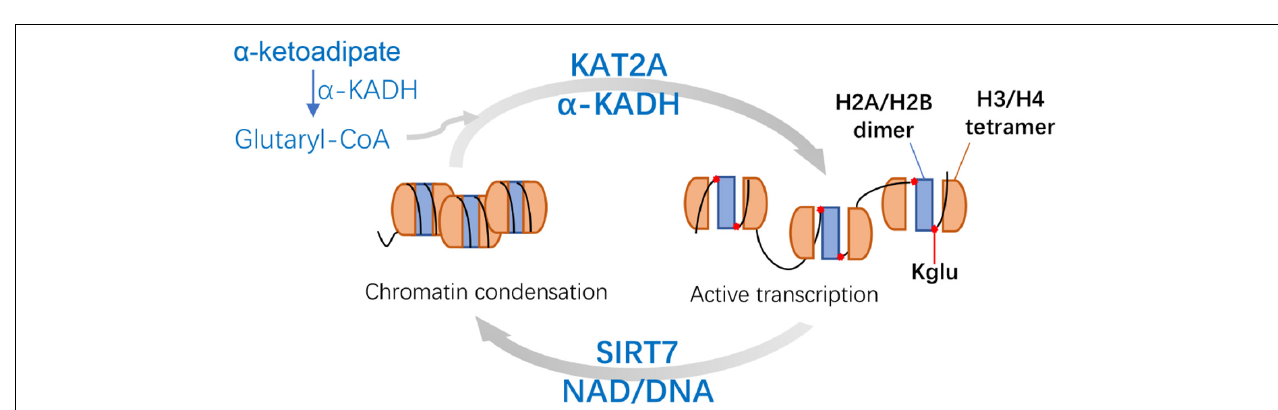
FIGURE 4 | Mechanisms and features of Histone H4 Lysine 91 glutarylation (H4K91glu). KAT2A is coupled with α -KADH to catalyze the H4K91glu as the histone glutaryl transferase. H4K91glu could regulate chromatin structure and enhance active gene expression. SIRT7-catalyzed removal of H4K91glu is related to chromatin condensation. KAT2A, lysine acetyltransferase 2A; α -KADH, α -ketoadipate dehydrogenase; NAD, nicotinamide adenine